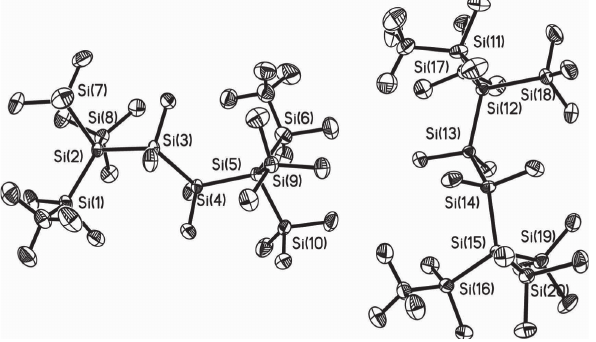
Table 1: Data collection and